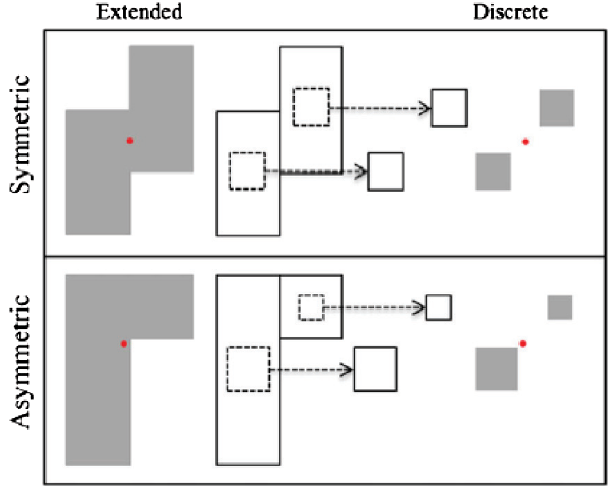
FIG. 2. A figure (Fig. 3) from Sattizahn et al. [11]. Subjects were shown a series of such shapes on a touch-screen device and asked to locate the center of gravity with a stylus. The original figure caption states that the red circle indicates the correct answer while the green circle is the average of all